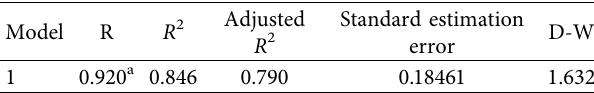
Table 6: Summary of multivariate analysis models b . Model